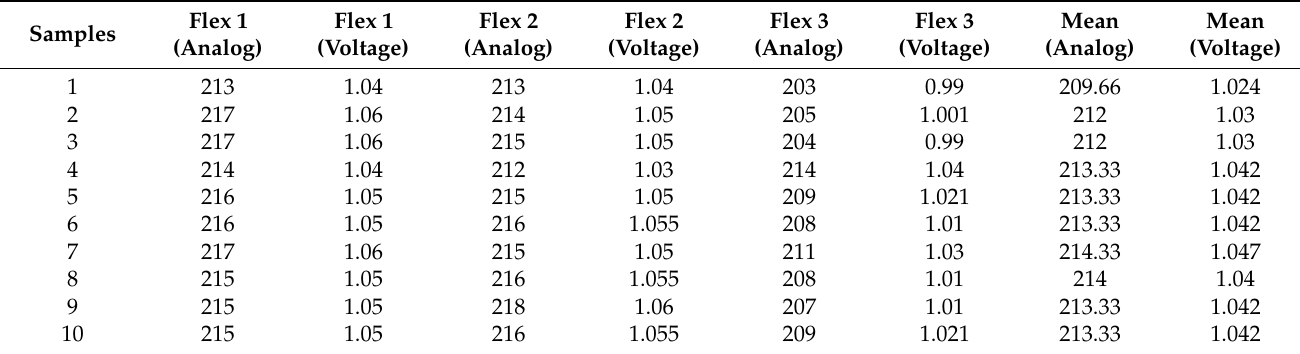
Table 2. The output of three flex sensors in analog and voltage with mean (Age group: 18–25 years, temperature 21 ◦ C to 27 ◦ C, February 2020).